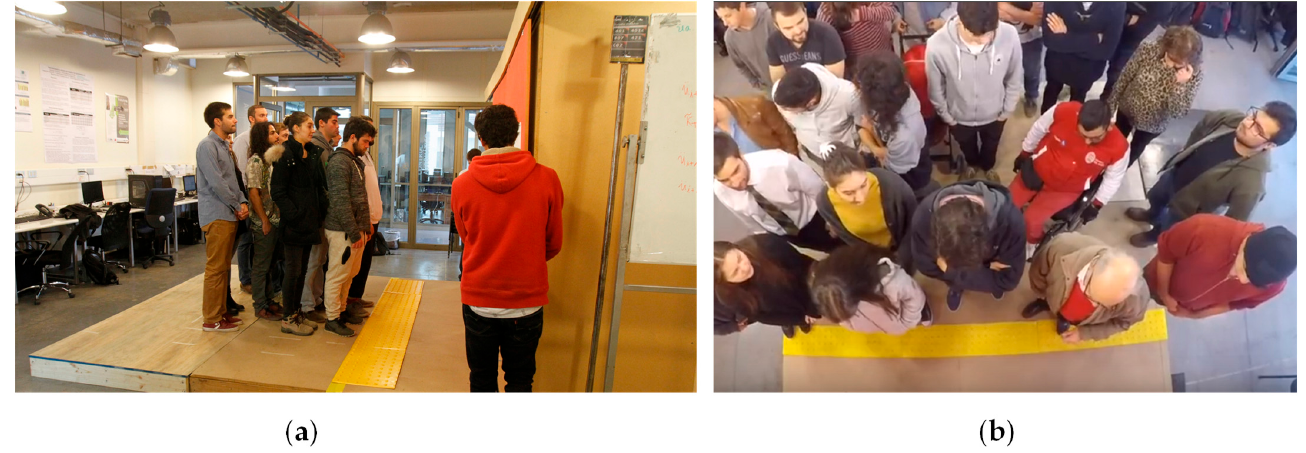
Figure 2. Laboratory experiments to represent the boarding and alighting: ( a ) lateral view of the platform when passengers are waiting to board the train and ( b ) top view of the platform when passengers are waiting to board the train.